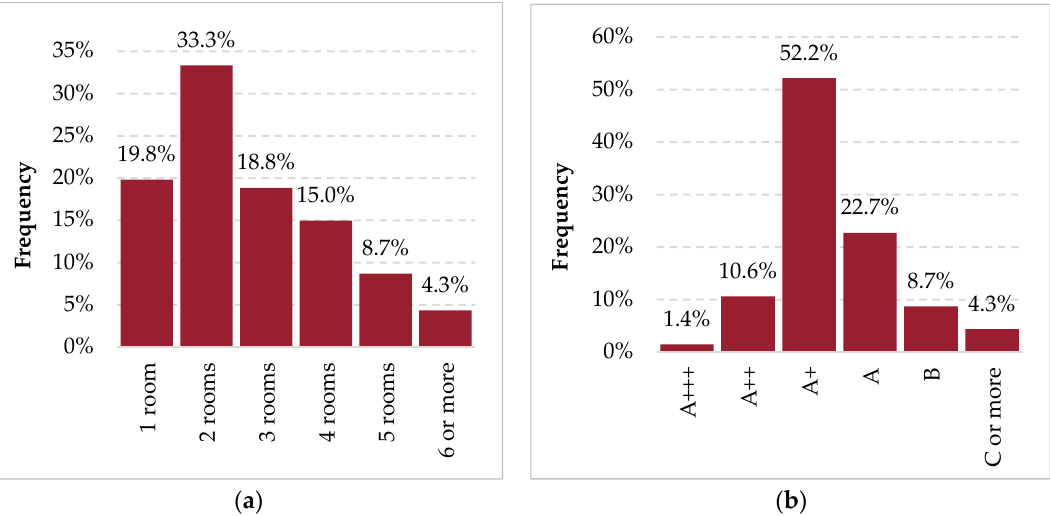
Figure 3. Cooling systems: ( a ) dwellings and number of air-conditioned rooms; ( b ) energy label.